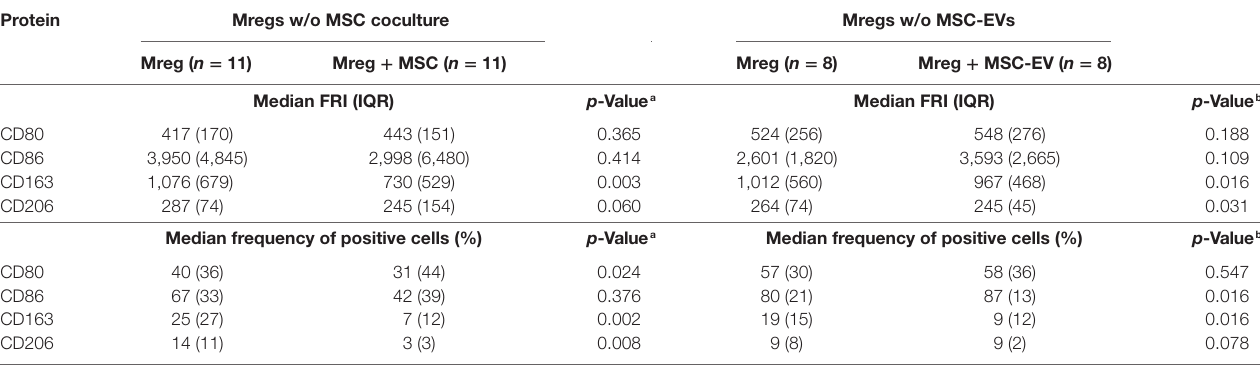
Table 2 | Effect of MSC coculture or MSC-EVs on Mreg phenotype.